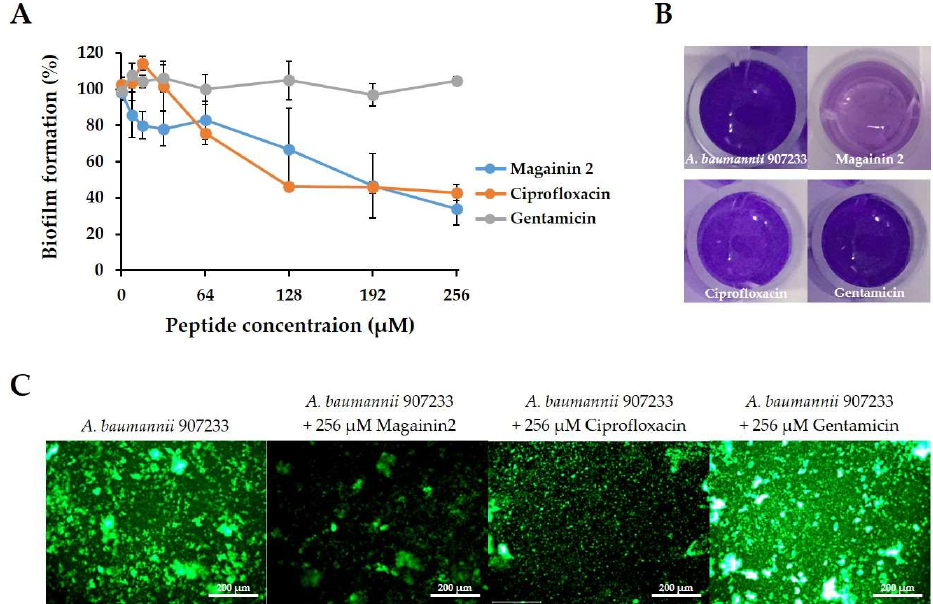
Figure 6. Biofilm reduction assay. ( A ) Degree of biofilm removal by magainin 2, ciprofloxacin, and gentamicin using crystal violet staining. ( B ) Image of removed biofilm after treatment with 256 µM of peptide and antibiotics. ( C ) SYTO9-stained biofilm image.